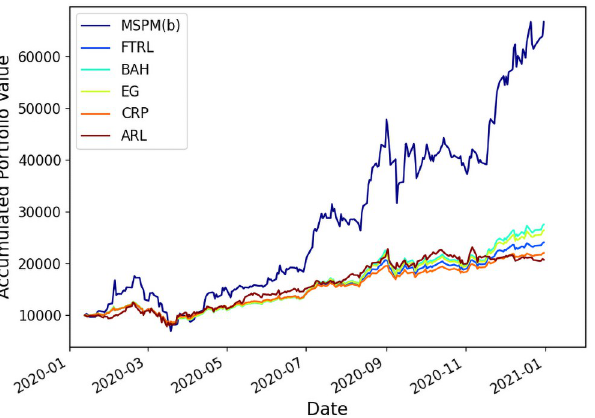
Fig 8. MSPM(b) outperforms all baselines on Portfolio(b) in terms of the accumulated portfolio value in back- testing. https://doi.org/10.1371/journal.pone.0263689.g008 higher adaptability to the ever-changing market compared to not only the traditional strategies but also the preceding RL-based method.